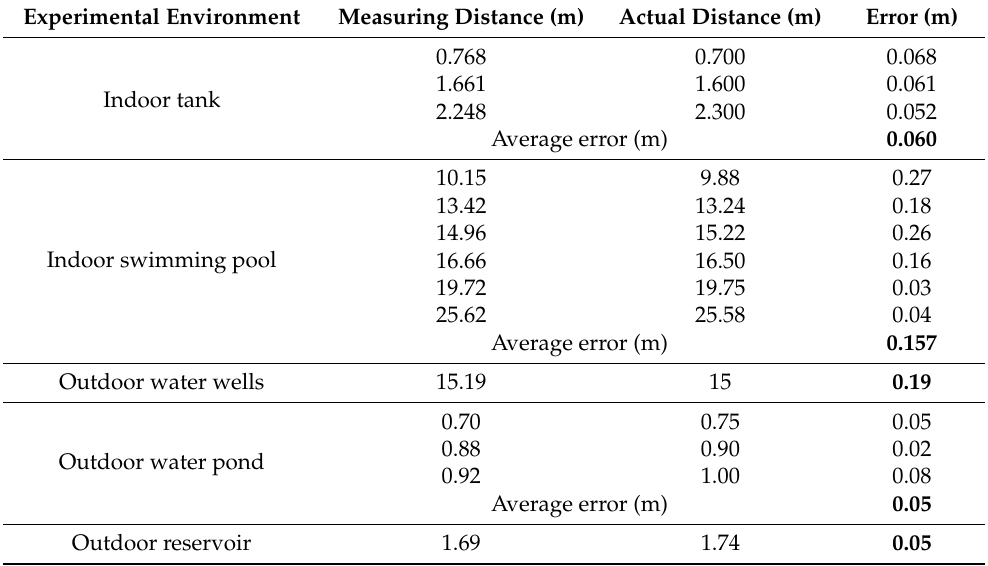
Table 7. The waveform data in different experimental